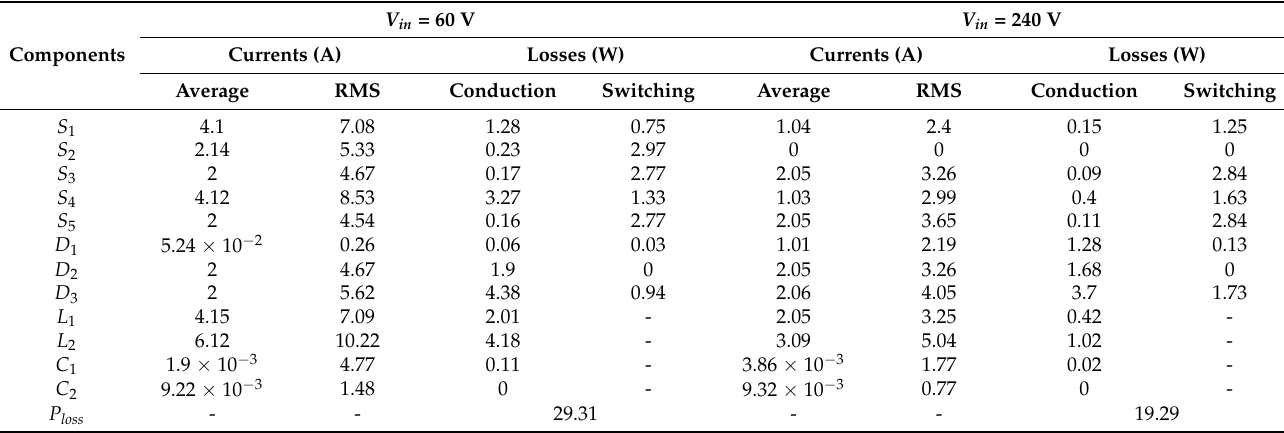
Table 3. The power loss of the proposed CGBBI with